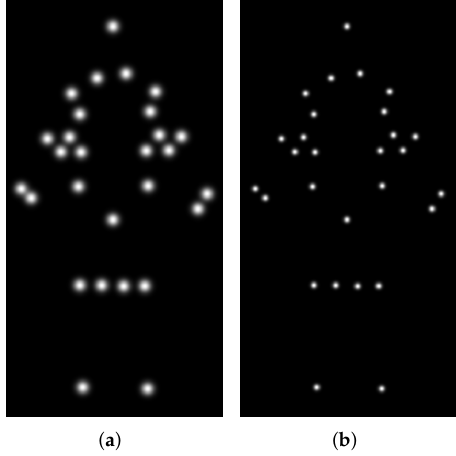
Figure 6. Heatmaps with different values of σ . The value of σ in ( a ) equals 3 and, in ( b ), σ equals 2. These two heatmaps allow our network to estimate the contour keypoints from coarse to